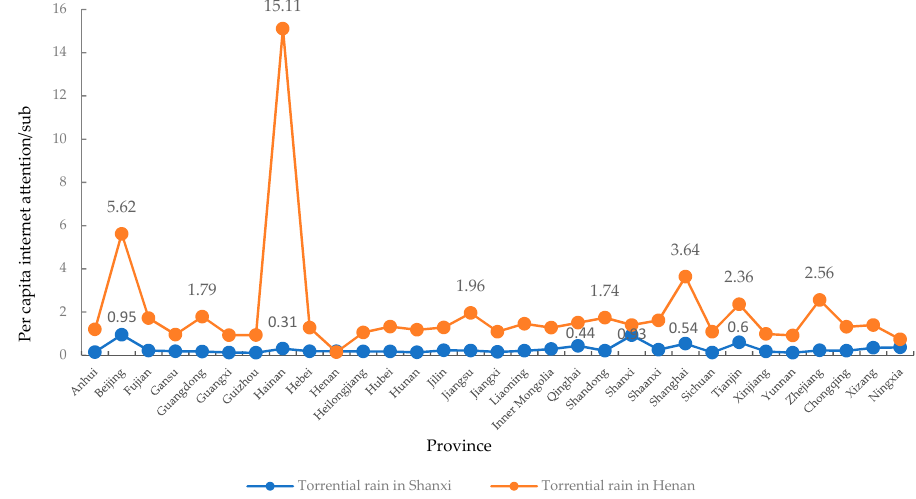
Figure 4. Trend of per capita internet attention by province in Shanxi and Henan torrential rain nationwide.